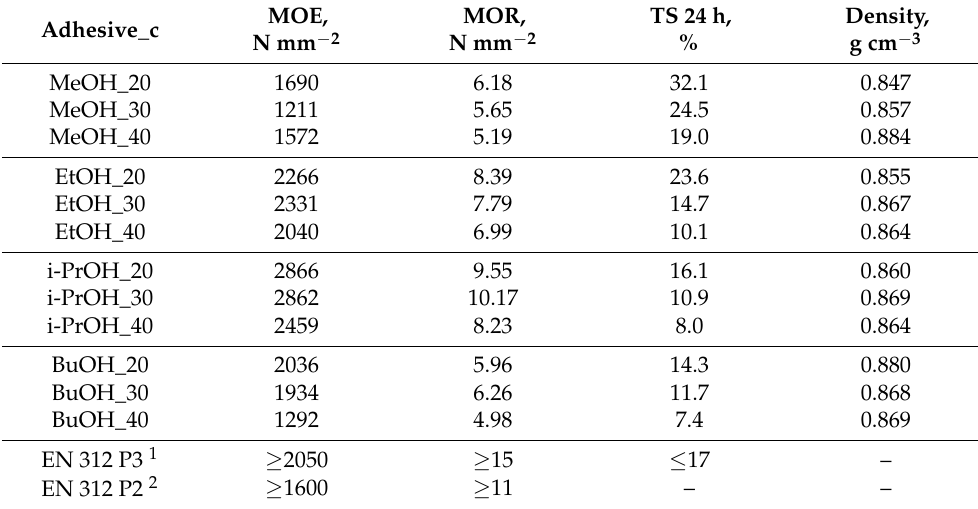
Table 7. Mechanical properties of particle boards obtained from MeOH, EtOH, i-PrOH and BuOH